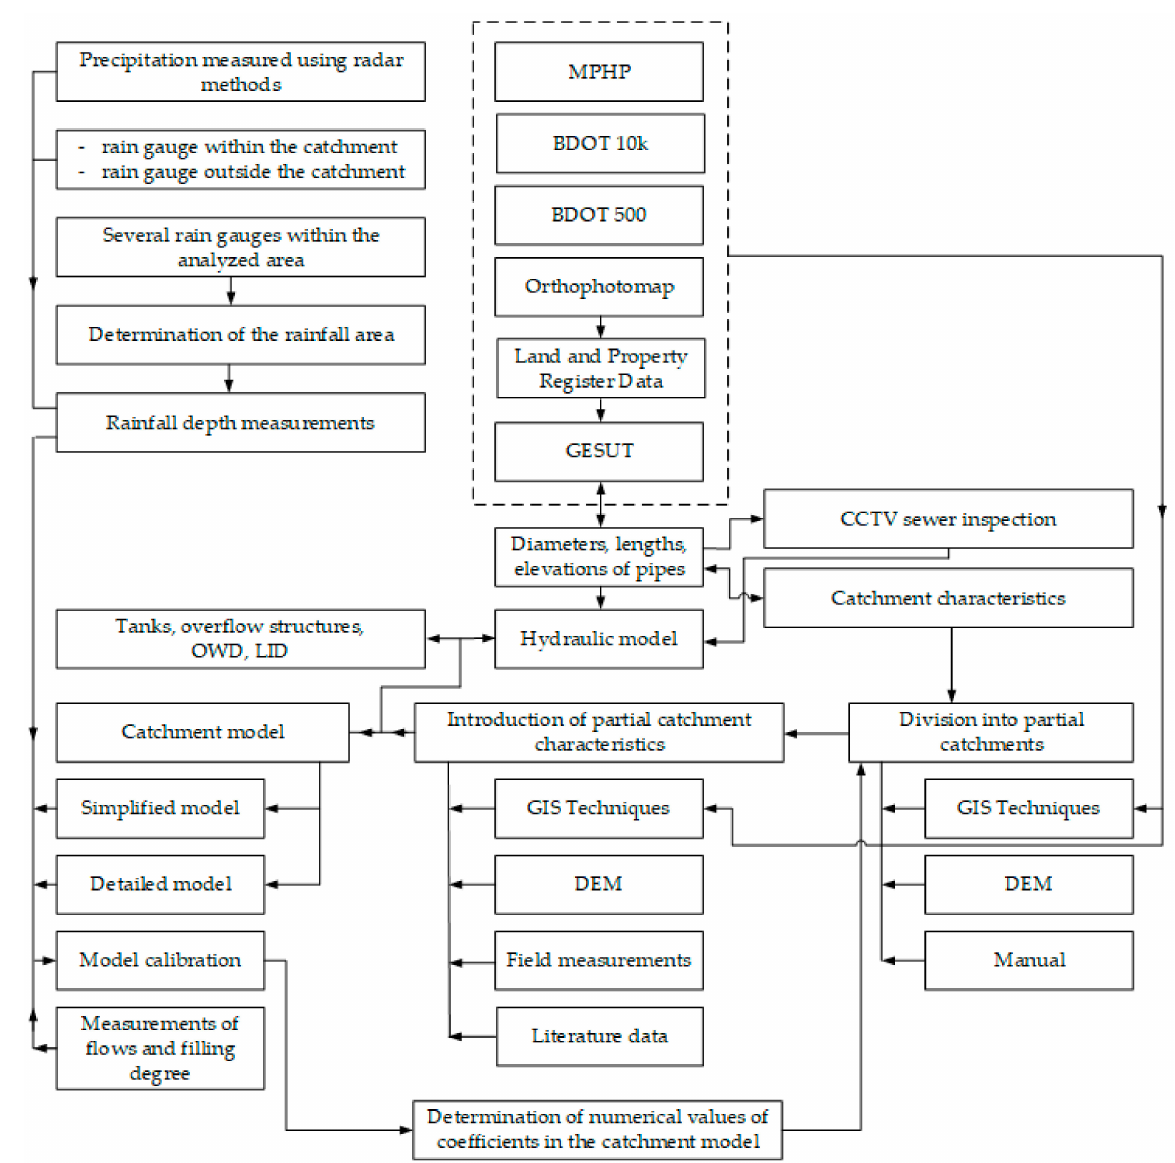
Figure 1. Concept scheme of a hydrodynamic rainfall-runoff model setup, including data collection and